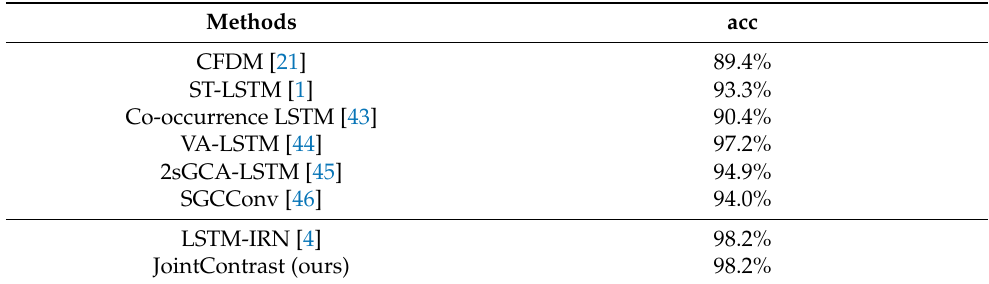
Table 2. The interaction recognition accuracy on the SBU dataset, accmeans recognition